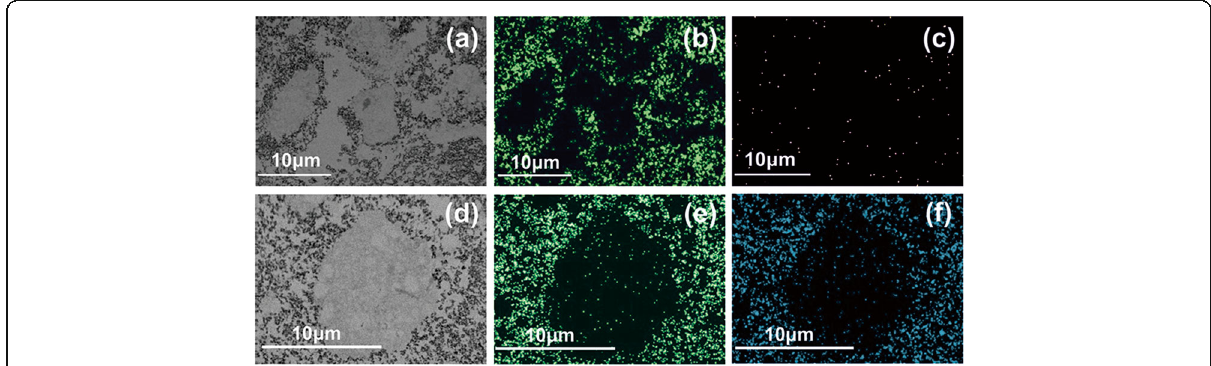
Fig. 11 TEM images and elemental analysis of RE-NPs at the surface boundaries of A549 cells. a TEM image of small size LaF 3 NPs surrounding the A549 cells. b Elemental analysis of F atoms in RE-NPs distributed around the cell. c Elemental analysis of La atoms. The low concentration of La atoms was associated with a rather small scattering efficiency of the X-rays. d – f The same as for ( a – c ) for PrF 3